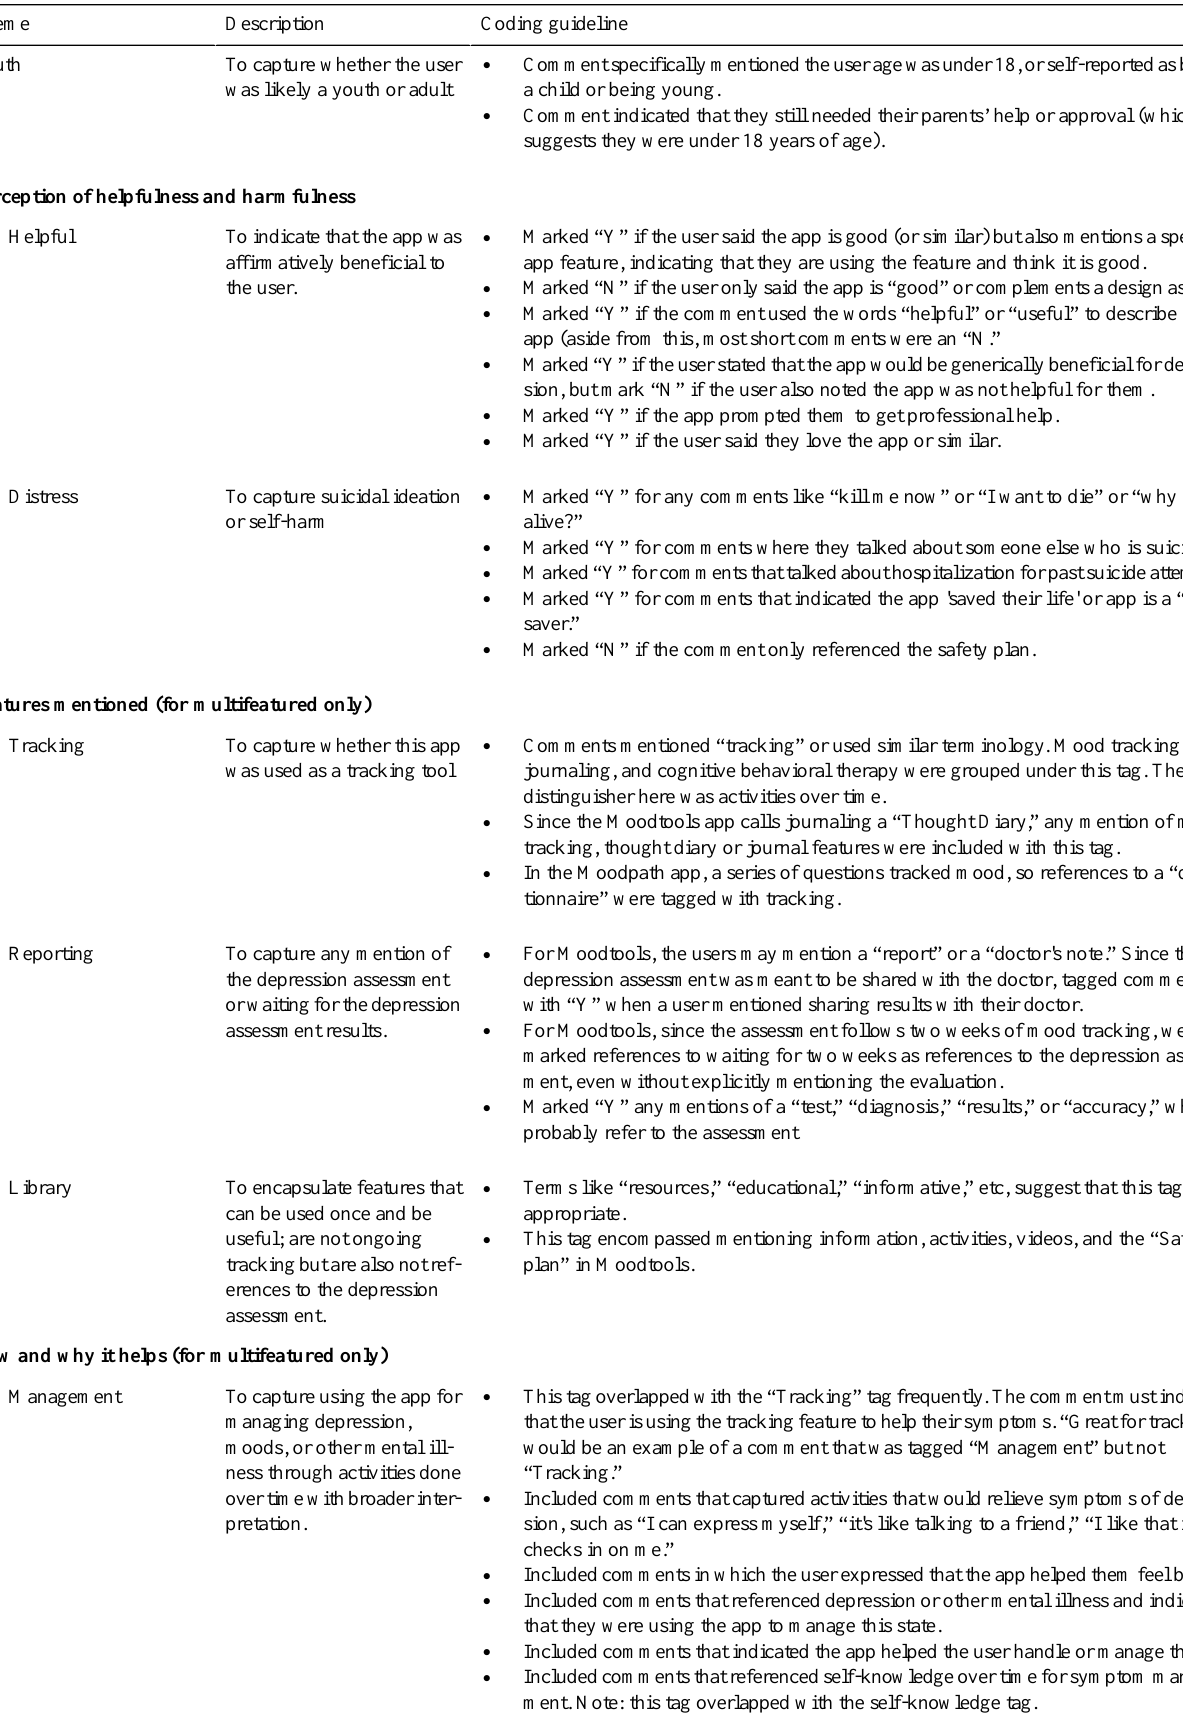
Table 2. Thematic coding guidelines and finalized